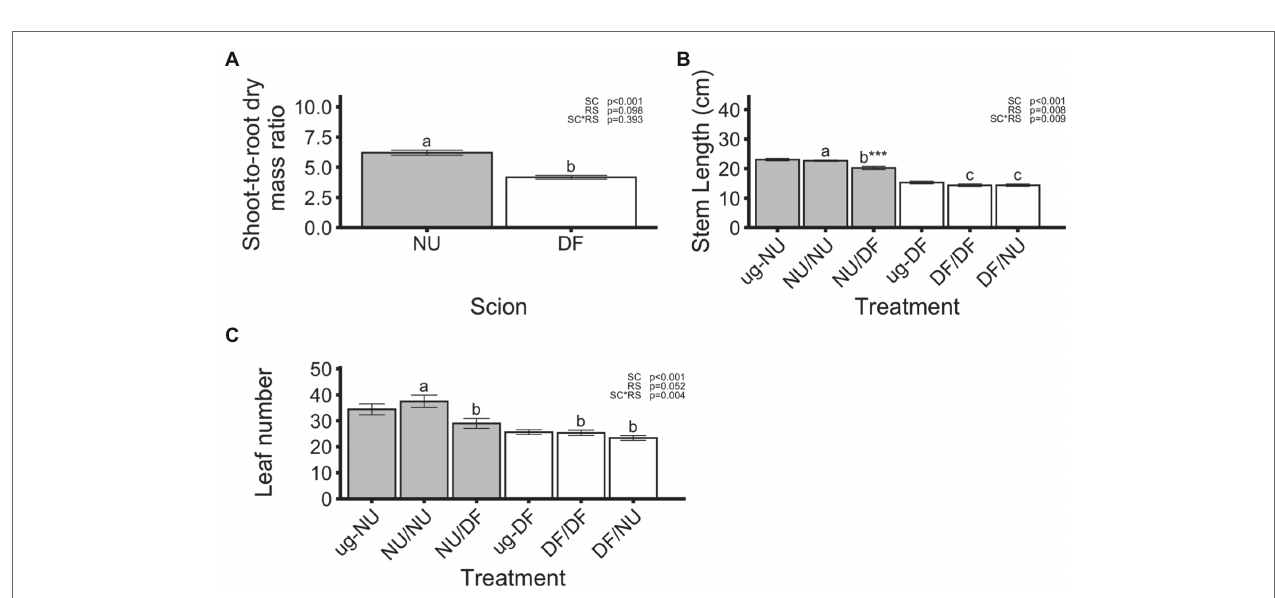
FIGURE 1 | Shoot dry mass in the first (A) and second (B) trial, root dry mass in the first (C) and second (D) trial. Values are means of 6 replicates for each treatment and error bars represent standard error. Asterisks above bars indicate significant difference between grafted treatment and the un-grafted control of the same scion cultivar by Dunnett’s test [***( p ≤ 0.001), **( p ≤ 0.01), and *( p ≤ 0.05)]. p -values indicate significance of scion (SC), rootstock (RS) and scion by rootstock interaction (SCxRS) effects from the factorial analysis of self- and inter-cultivar grafted plants (four treatments excluding un-grafted controls). Letters indicate mean separations for the four grafted treatments by Tukey’s HSD ( p ≤ 0.05) applied when SCxRS interaction was significant. Gray and white bars represent plants with NU and DF shoot systems, respectively.